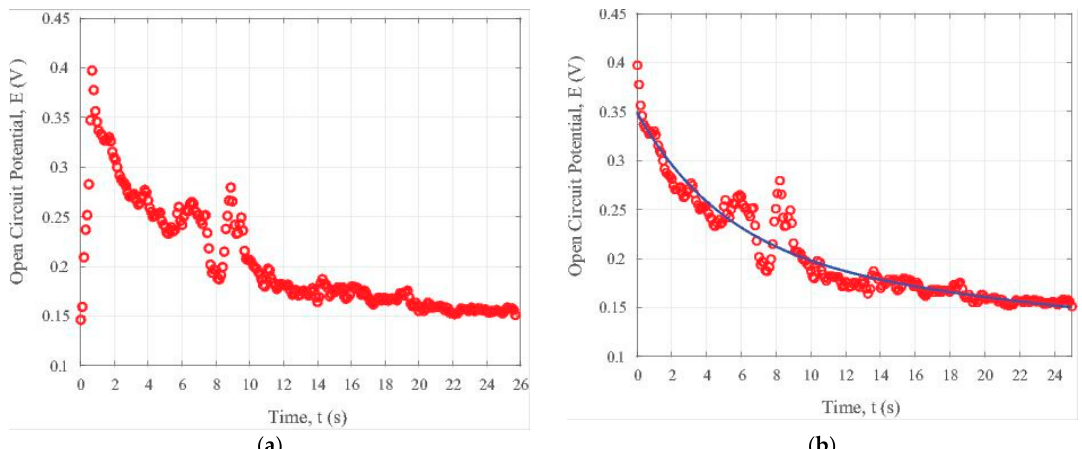
Figure 5. Transient photonic response of the iron oxide nanoparticle-loaded carbon fiber specimen under visible light illumination: ( a ) without data fitting, ( b ) with data fitting.